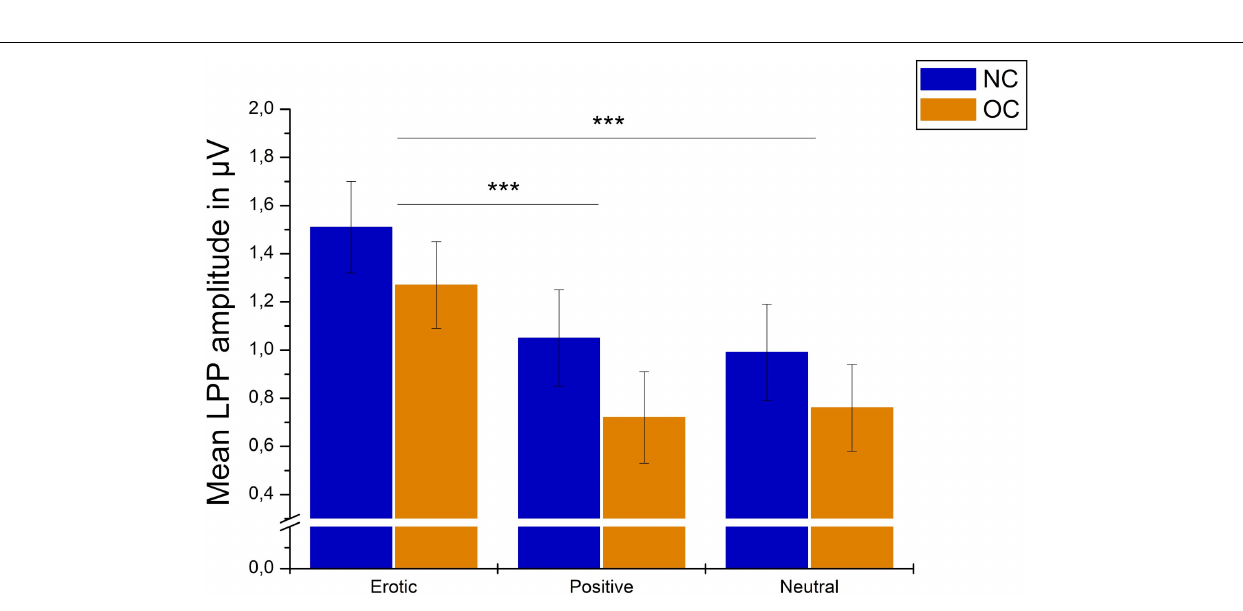
Frontiers in Neuroscience |